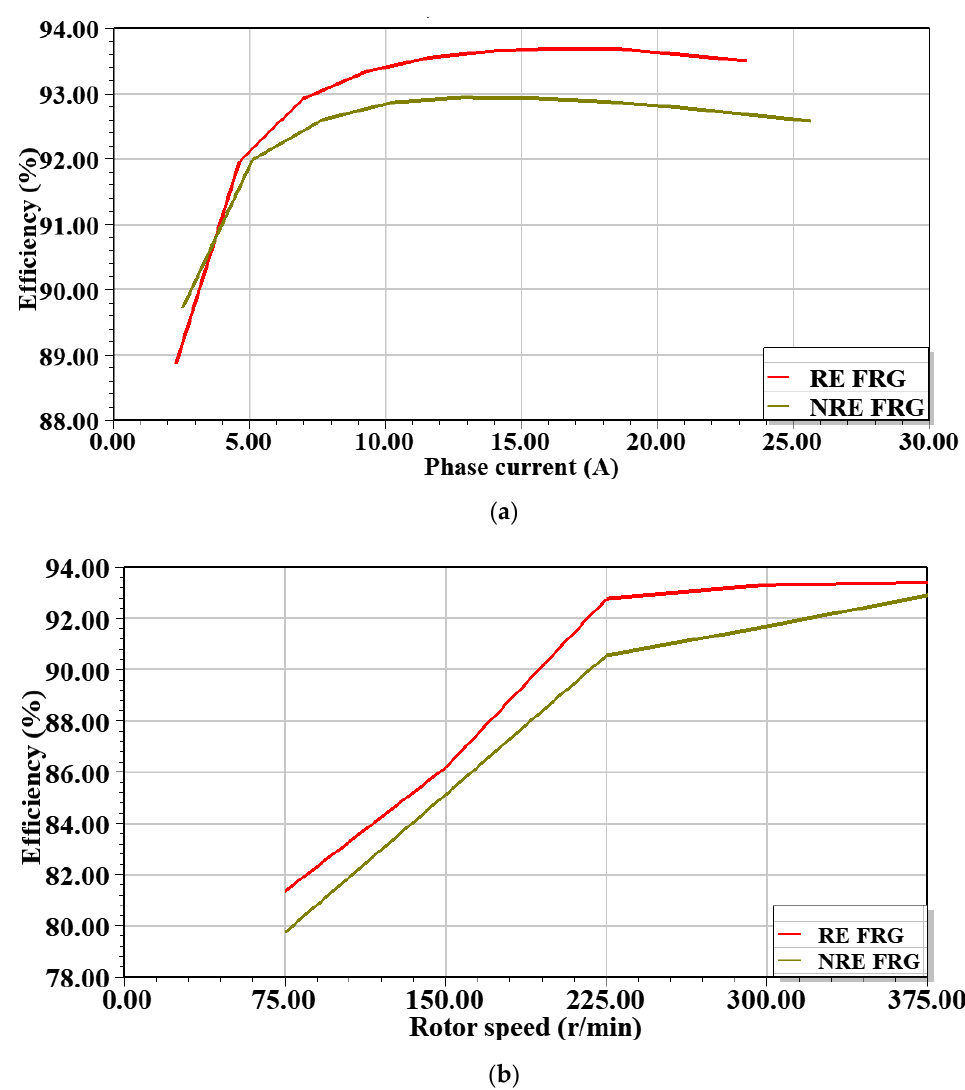
Figure 8. ( a ) On-load phase current vs. efficiency at 375 r/min; ( b ) generator speed vs. efficiency at rated load current.